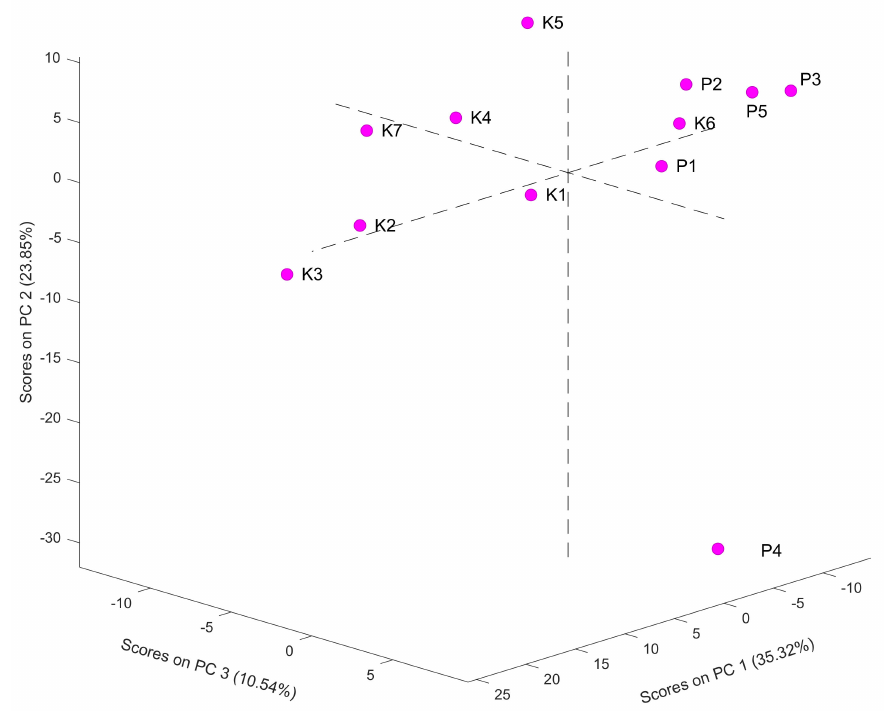
Figure 4. PCA analysis performed on the data from the ATR–FTIR analysis of bee pollen samples K1–K7 and P1–P5.